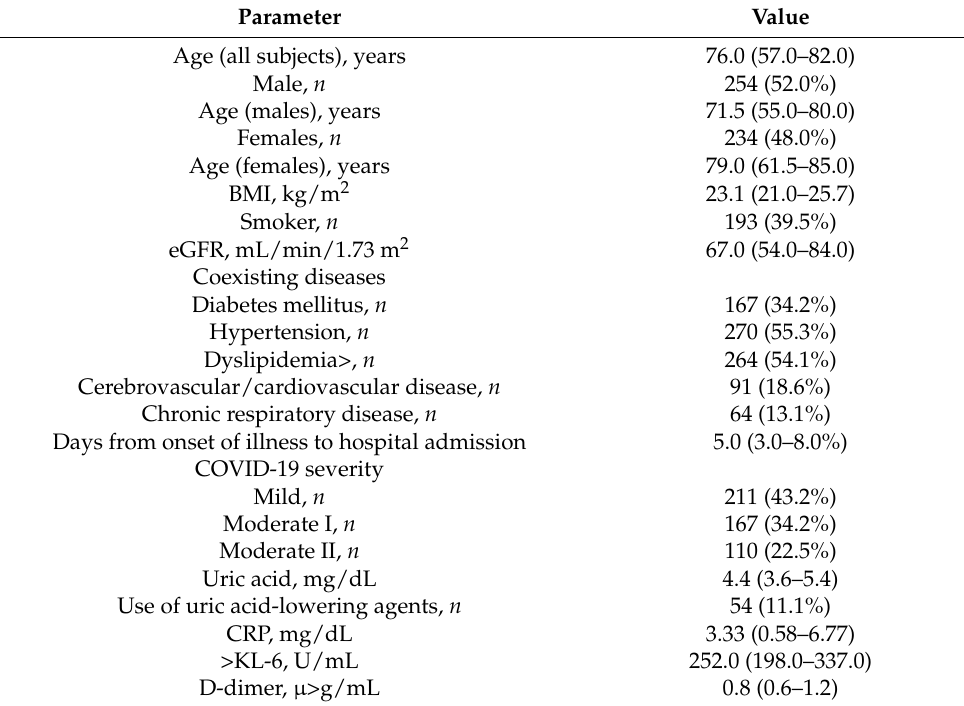
Table 1. Clinical characteristics of patients with coronavirus disease 2019 (COVID-19) ( n =